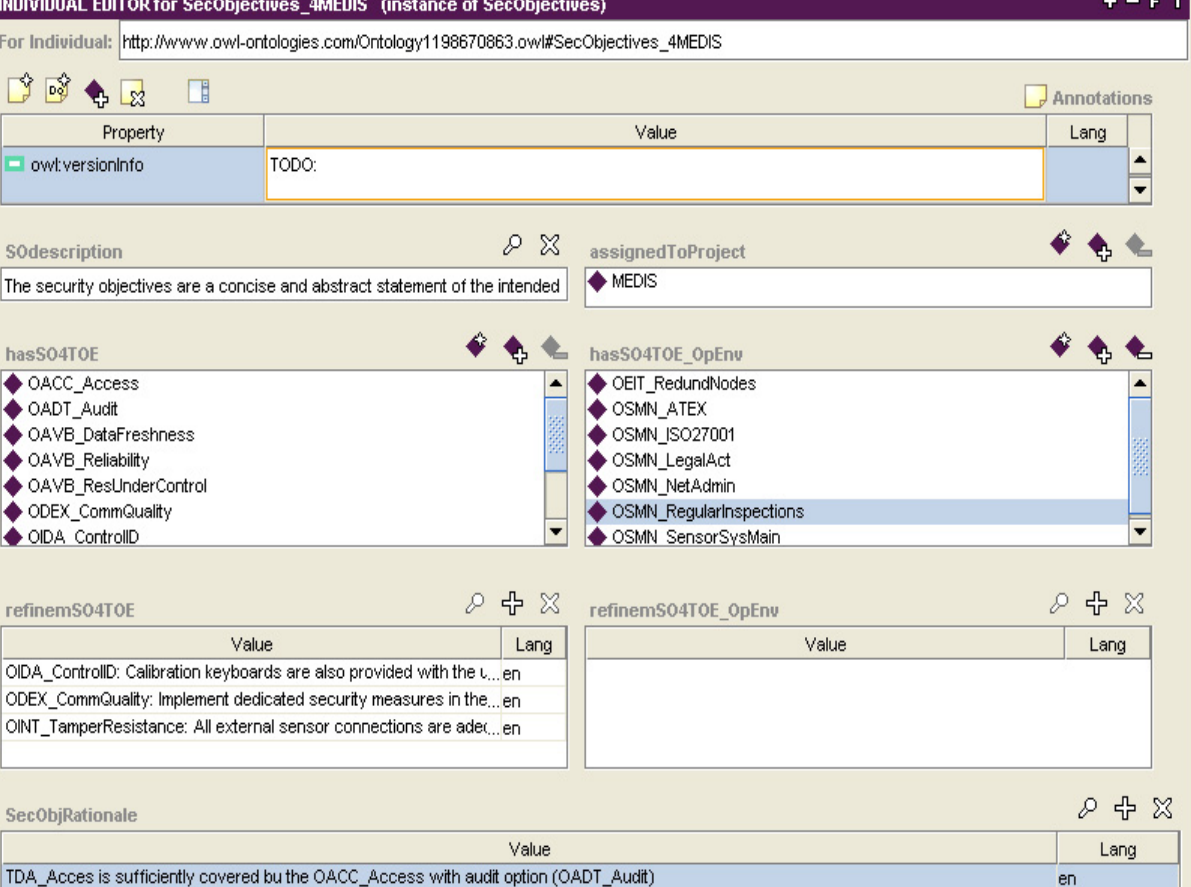
Figure 5. The MEDIS security objectives in the Protégé tool